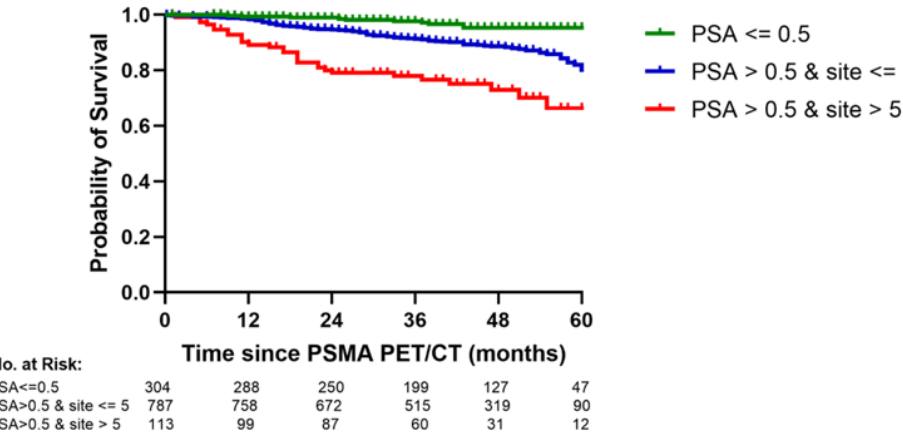
Figure 4. A new risk model shows a significant difference in overall survival between the good-, intermediate-, and poor risk groups ( p < 0.0001). The figure compares the overall survival for two patient groups by the number of positive findings on restaging PSMA PET/CT: 1–5 sites vs. > 5 sites.